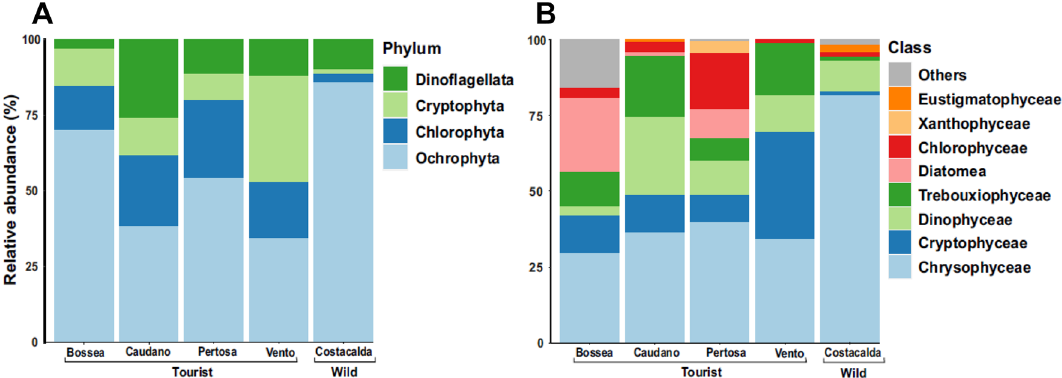
Figure 5. Micro-algal assemblage composition of 5 caves studied: Bossea, Caudano Pertosa-Auletta, del Vento (show-caves) and Costacalda (wild cave). All taxa observed are shown for taxonomic ranks: phylum ( A ) and class ( B